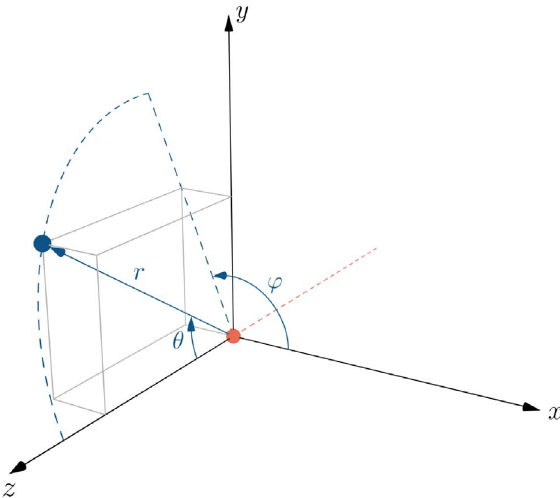
Figure 1. Cartesian and spherical coordinates with the drone (as red dot) at the origin. The dashed red line represents past